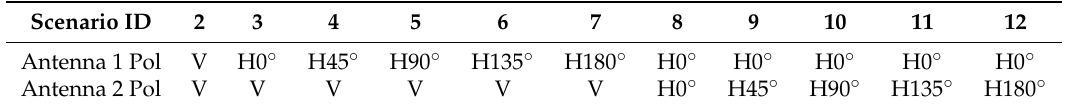
Table 2. Antenna configuration per Scenario